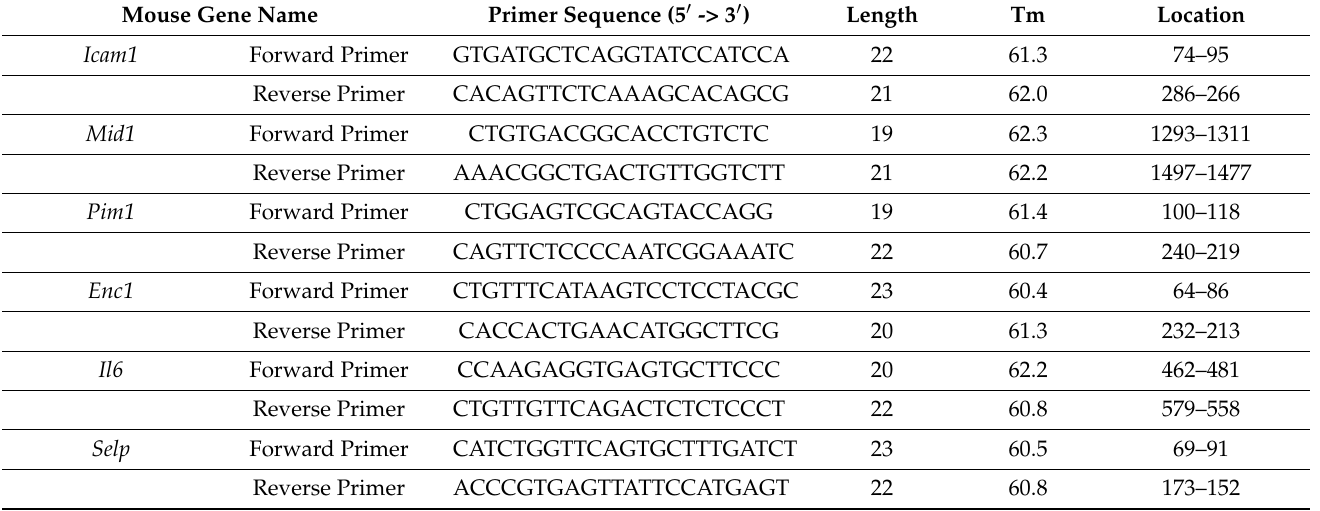
Table 4. List of primers for validation by